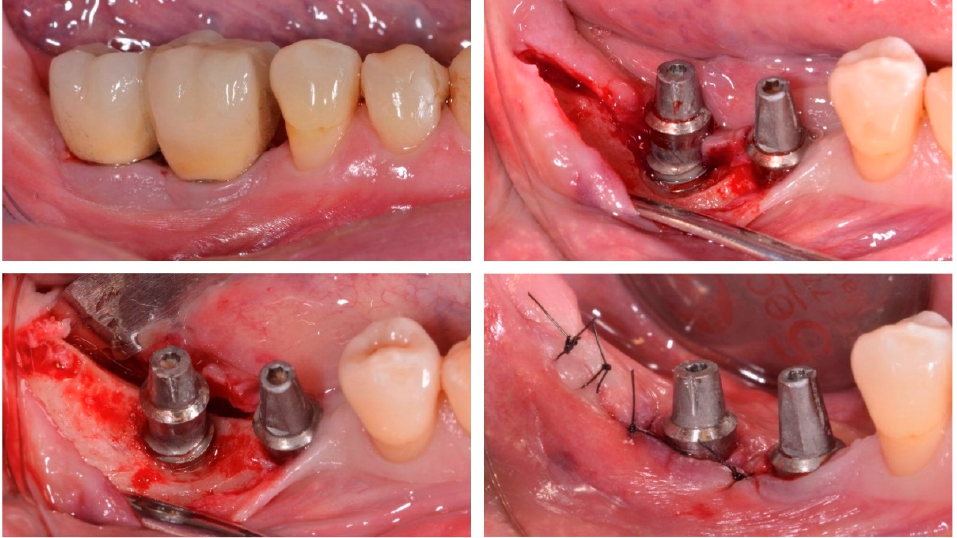
Figure 1. The surgical approach consisted of raising access flaps and implant surface decontamination.